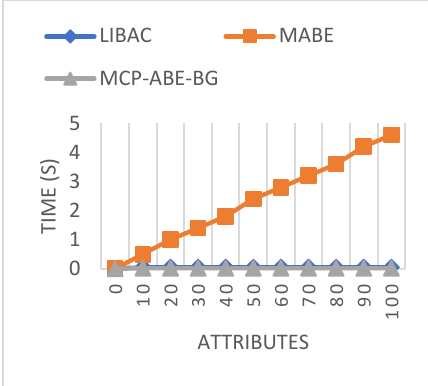
Figure 7. Encryption time comparison.